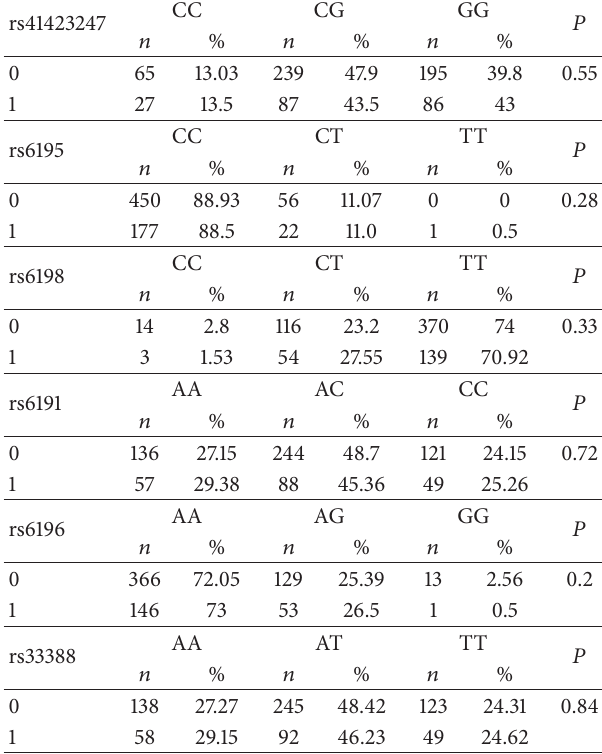
Table 1: Polymorphisms in GR ( NR3C1 ) gene (genotypes).